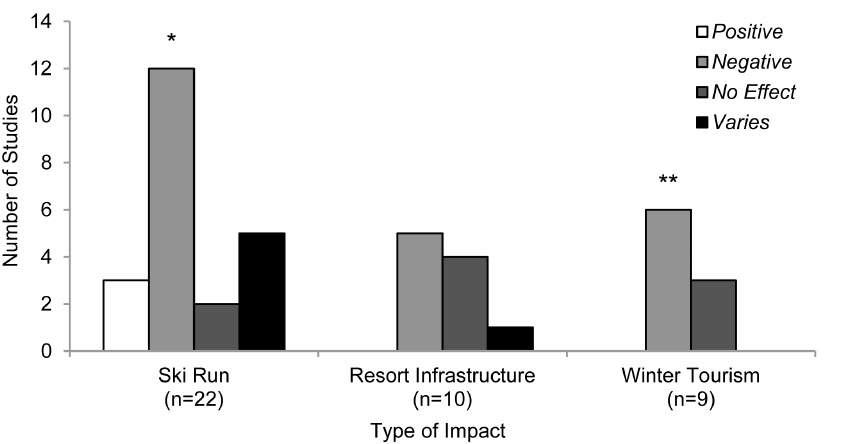
Figure 8. Number of studies (n=41) investigating the effect of three different types of winter recreation-related disturbance on fauna. *P , 0.05, **P , 0.01 indicate a significant difference between the number of positive and negative effects reported.